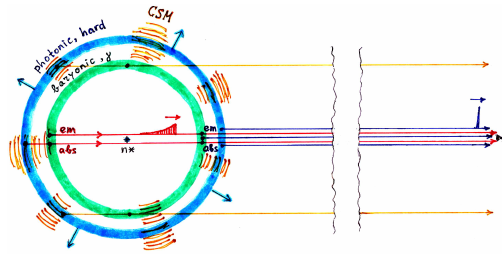
Figure 3: Schematic drawing of the expected ejec- tion geometry of a GRB by a magnetar: An ultramas- sive clump from the inner edge of its (low-mass) accre- tion disk hits the surface of the central neutron star, heats up, expands, and gets seized and centrifugally re-ejected by the magnetar’s strong, corotating magne- tosphere, near its speed-of-light distance, with Lorentz factors γ (cid:46) 5. As a result, a hard electromagnetic flash is emitted (mostly peaking near 1 MeV, but ranging from radio frequencies up through IR, optical, X-ray, and γ -ray frequencies all the way towards and beyond 10 2 GeV photon energies), closely followed by a centrifu- gally ejected transrelativistic hadronic shell. This cou- ple of two more or less radially emitted and/or boosted transrelativistic shells of ejecta impact on the GRB’s CSM, they both heat up, and give rise to the burst’s prompt and afterglow emissions, as well as to the evolv- ing appearance of a ‘host galaxy’. This model can be shown to be flexible enough to account for all the ob- served GRBs, including their intrinsic differences, and occasional anomalies, such as short and long bursts (due to repeated accretions), pre-cursors and post-cursors (for the same reason), redshifts, early afterglow oscil- lations (by the output of the spinning central neutron stars), strong flaring of the X-ray afterglows (during collisions with the CSM), linear polarisations (for scat- tered radiation), and so on and so